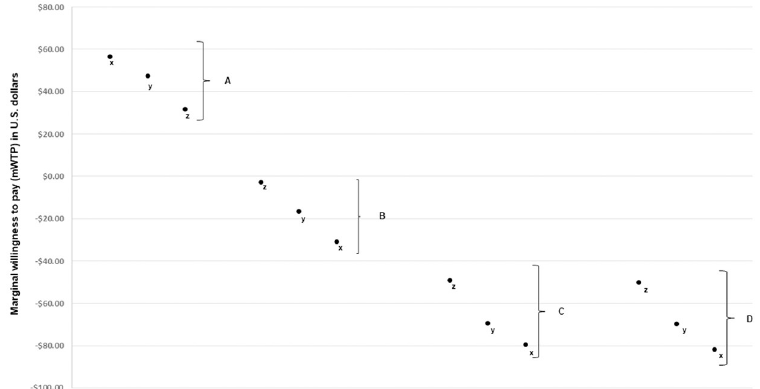
Fig 6. Marginal willingness to pay for PrEP by insurance type for various insurance coverage scenarios among 236 young MSM. A. PrEP is private (employers or family members cannot see benefits used); B. PrEP is not insurance covered; C. PrEP requires extra insurance; D. PrEP requires switch to a new insurance. Baseline insurance status. x. Participants on parental insurance; y. All participants, regardless of insurance status; z. Participants with employer- based exchange-based